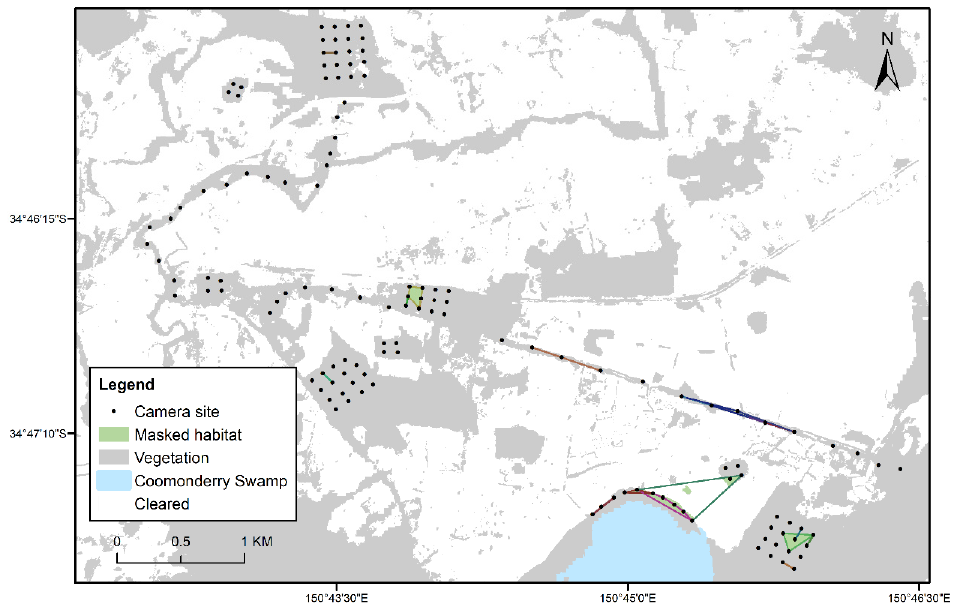
Figure 5. Polygons formed by connected sites for 20 brown antechinus ( Antechinus stuartii ) where individuals (females = 9, males = 11) were observed on at least two selfie trap sites. Useable habitat within polygons (masked habitat) is highlighted in green.